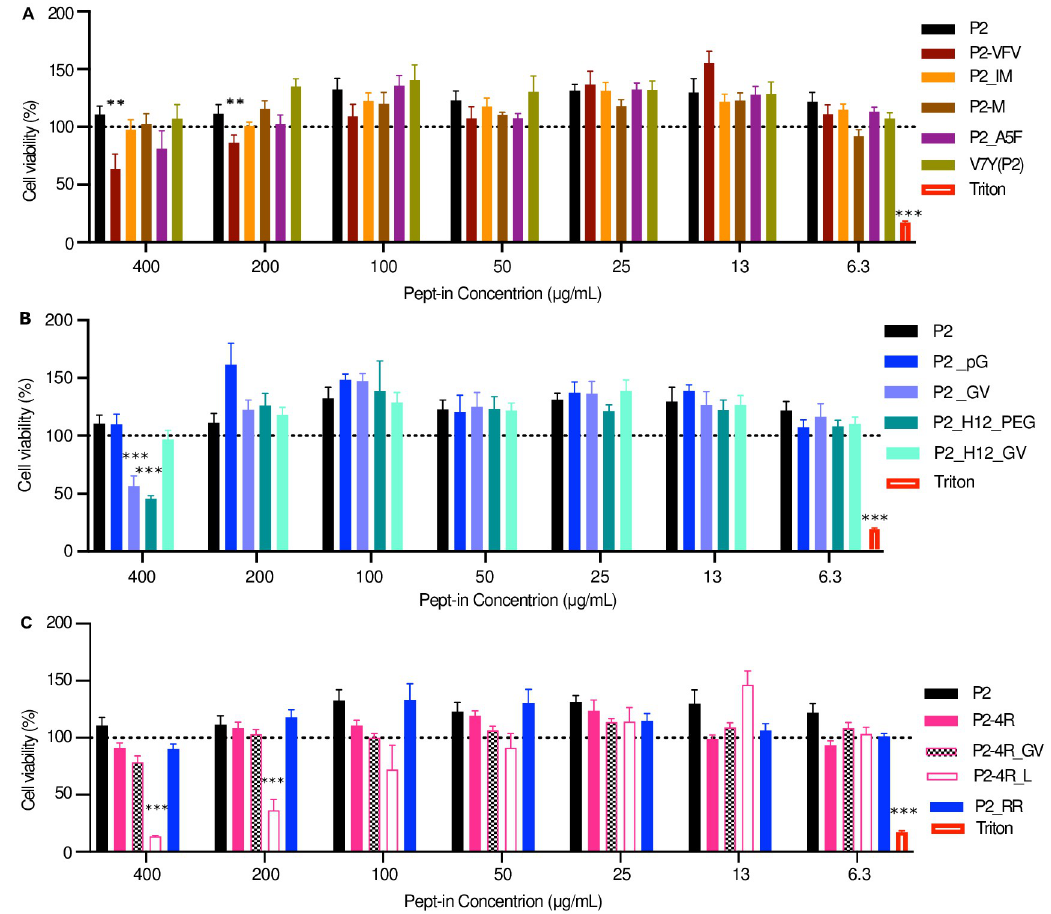
Fig 6. Enhancing antimicrobial potency while exhibiting no toxicity to mammalian cells. A-B: Concentration-dependent toxicity by CellTiter Blue assay on HEK 293T cells for P2 and derivatives with improved antimicrobial potency. A: Derivatives with increased aggregation propensity or compatibility to the aggregate core structure. B: Derivatives of linker modification or cysteine addition. C : Derivatives of altered number of arginine residues. Error bars represent SEM. Two-tailed Student t-test was performed for calculating statistical significance between the mean of P2 variant and P2 at the corresponding concentration (n = at least 6). Asterisks indicating the level of the p-value centred over the error bar mean: * p < 0.05, ** p < 0.01, *** p < 0.001, and **** p <